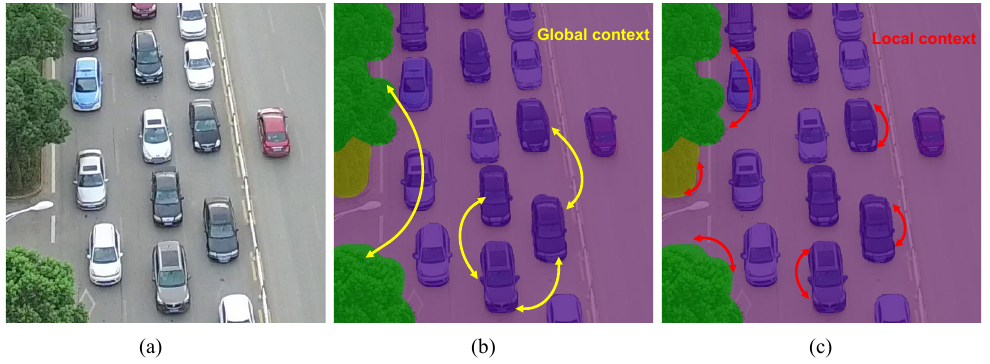
Figure 1. Illustrating global and local context information for UAV image semantic segmentation. ( a ) Input image. ( b ) Global context modeling. The yellow arrows represent the global contextual information. ( c ) Local context modeling. The red arrows represent the local contextual